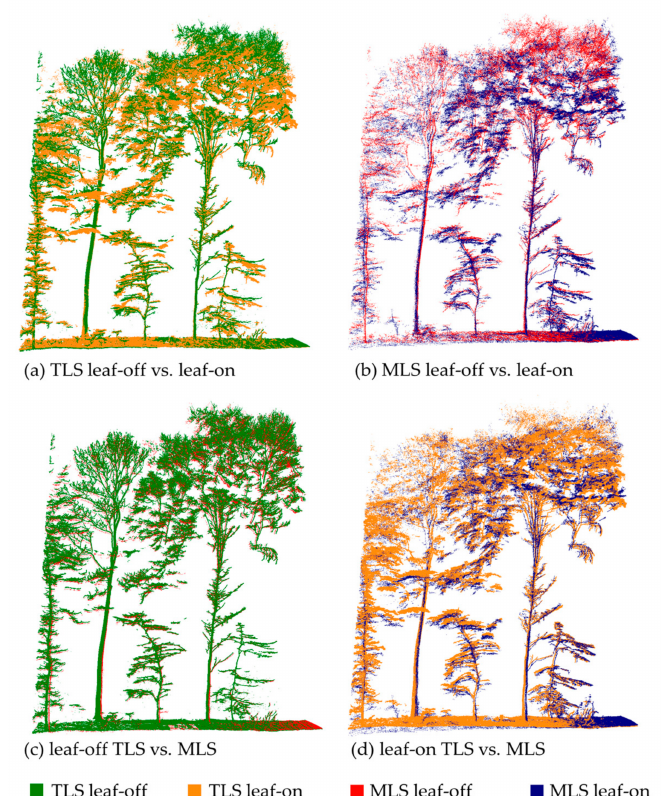
Figure 14. Comparison of the multi-temporal TLS and MLS point clouds of plot 1 on the example of a 3 m wide profile perpendicular to the scan trajectory of the MLS